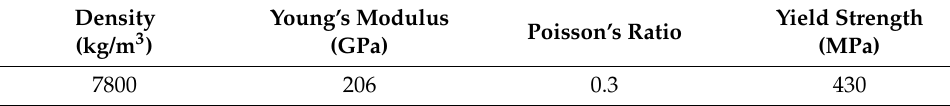
Table 3. Material properties of steel